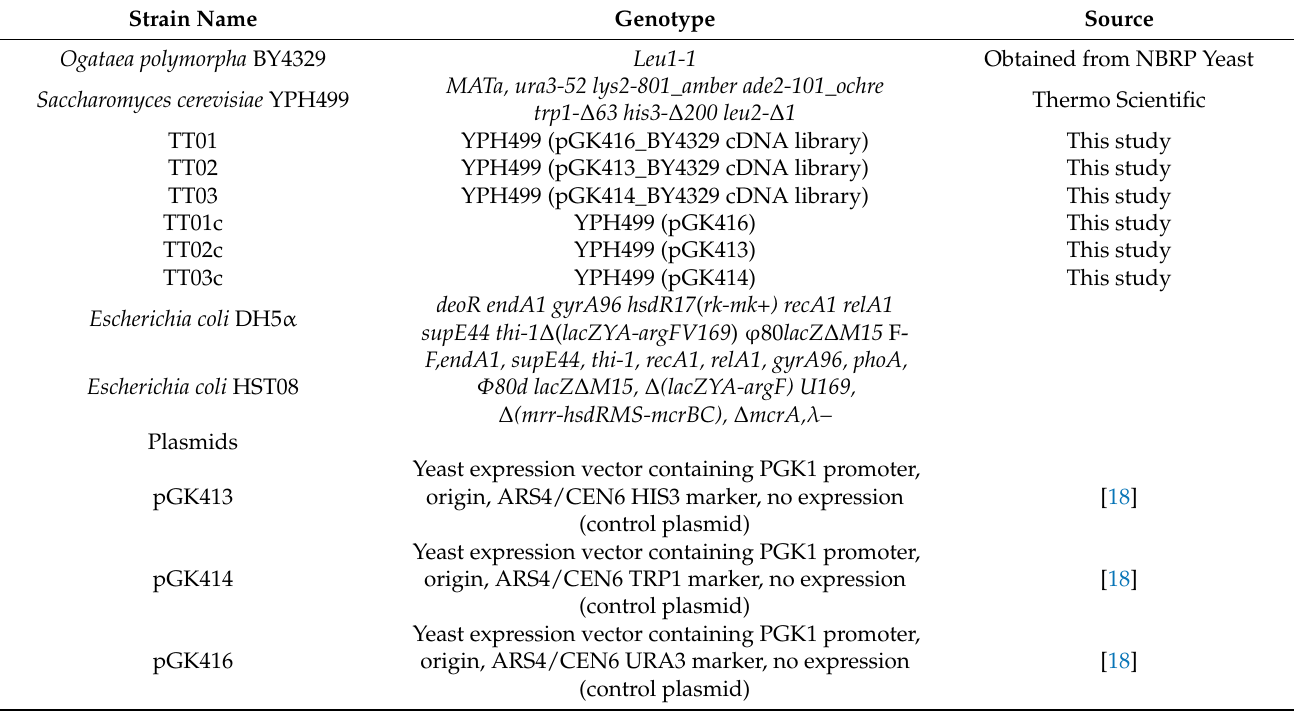
Table 1. Strains and plasmids used in this